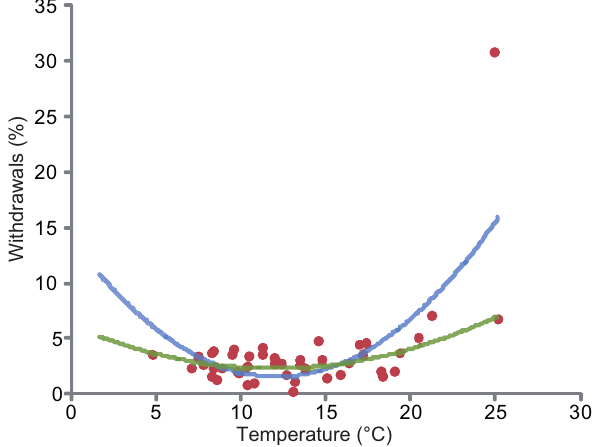
Figure 4. Relationship between air temperature and the percentage of runners’ withdrawals, modeled with a quadratic fit (blue curve, r 2 =0.36; p , 0.0001). The green curve represents the quadratic fit without the maxima (Chicago 2007: 30.74% withdrawals at a race temperature of 25 u C).